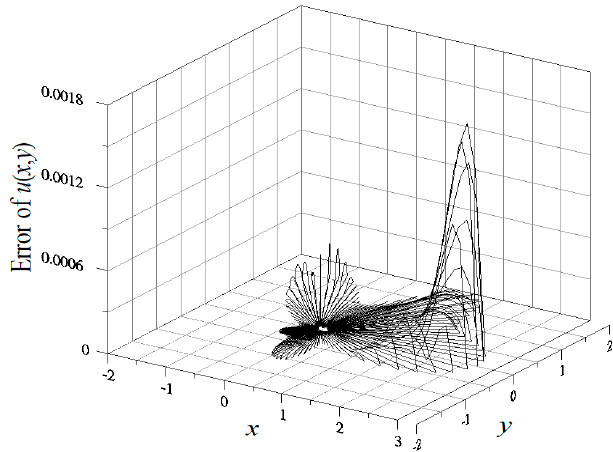
Figure 19. The numerical errors of the proposed method solution for the steady-state AC equation with the amoeba-like irregular domain.